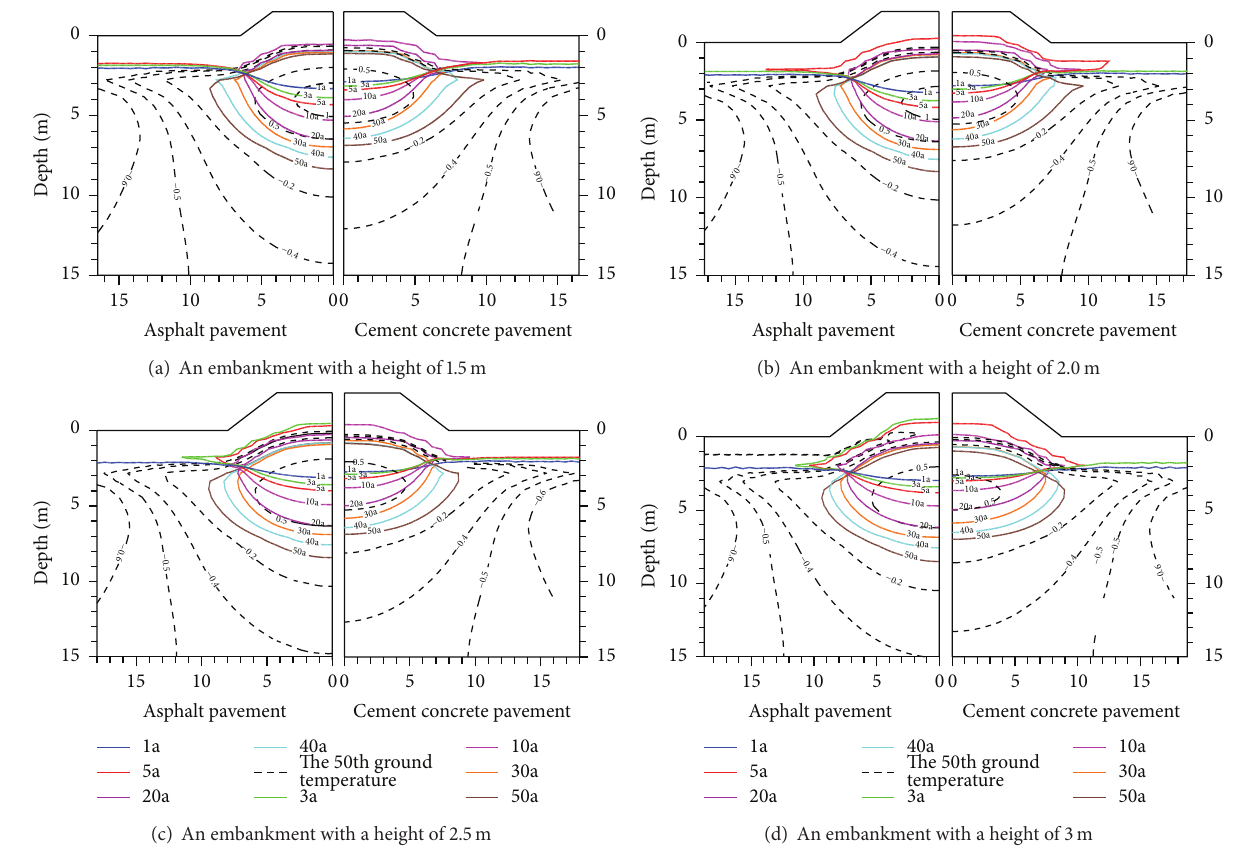
Figure 6: Variations of the maximum thawed depth and temperature value of the 50th year under concrete pavement and asphalt pavement (width of 8.5